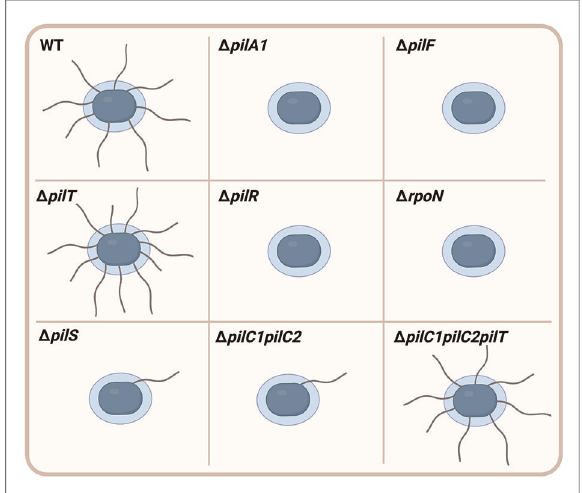
FIGURE 1 Piliation phenotypes in K. kingae mutants. Wild type ( WT) K. kingae bacteria (blue) produce high levels of fi lamentous surface fi bers called type IV pili. Deletion of the pilA1 gene ( Δ pilA1 ) encoding the PilA1 major pilin subunit results in abrogation of surface pili. The pilus fi ber is assembled by an assembly ATPase PilF, and deletion of the pilF gene ( Δ pilF ) prevents surface piliation. T4P retraction is controlled by the PilT retraction ATPase, and deletion of the pilT gene ( Δ pilT) results in higher levels of surface piliation compared to WT. Expression of the pilA1 gene is controlled by the PilR/S two-component system and the σ factor σ 54. Deletion of pilR ( Δ pilR ) and the gene encoding σ 54 ( Δ rpoN ) abrogates surface pili. However, deletion of pilS ( Δ pilS ) results in very low levels of surface piliation compared to WT. Elimination of both the PilC1 and PilC2 pilus-associated adhesins ( Δ pilC1pilC2 ) signi fi cantly decreases levels of surface pili compared to WT. However, surface piliation is restored to WT levels following additional deletion of the pilT gene ( Δ pilC1pilC2pilT ), suggesting that PilC1 and PilC2 promote surface piliation through counteracting retraction of the fi